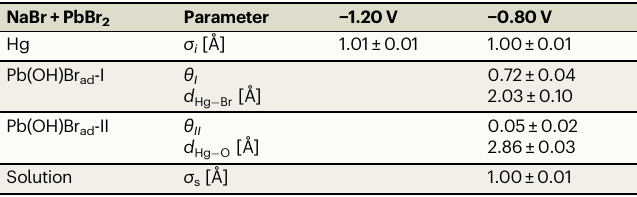
Table 1 | Structural data on the precursor adlayer formed in Br-containing